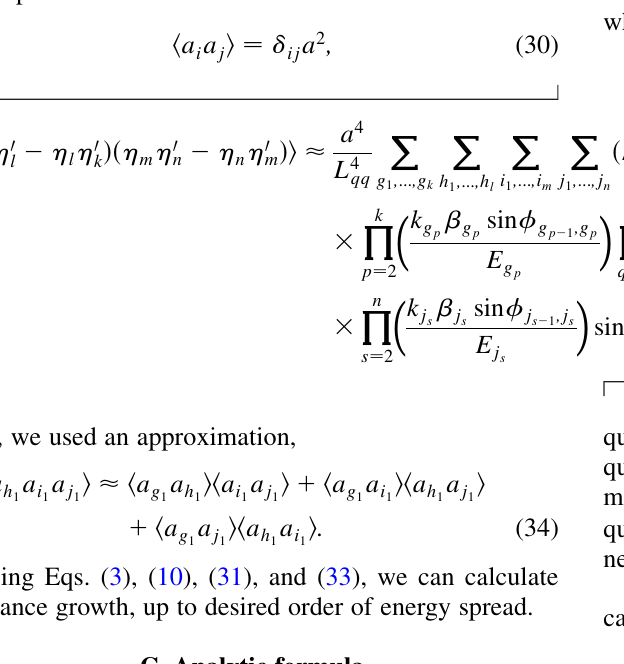
ffiffiffiffiffiffiffiffiffiffiffiffiffi